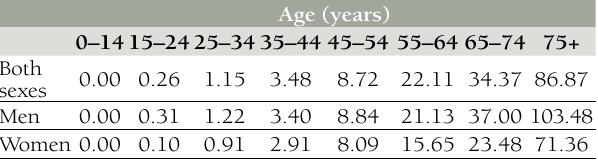
Table 2 Crude annual incidence of colorectal cancer in